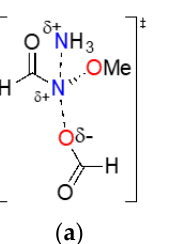
Figure 12. HF/6-31G* predicted charge separation in transition states for reactions of N -formyloxy- N - methoxyformamide with ( a ) ammonia and ( b ) methanethiol.